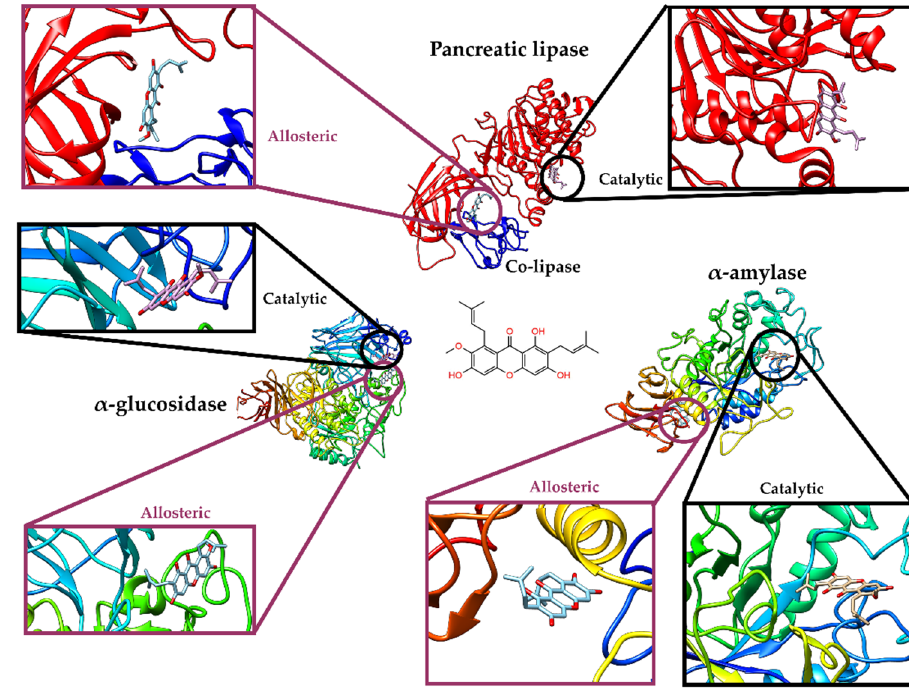
Figure 2. Molecular docking of compound 4 against PL, AA and AG.